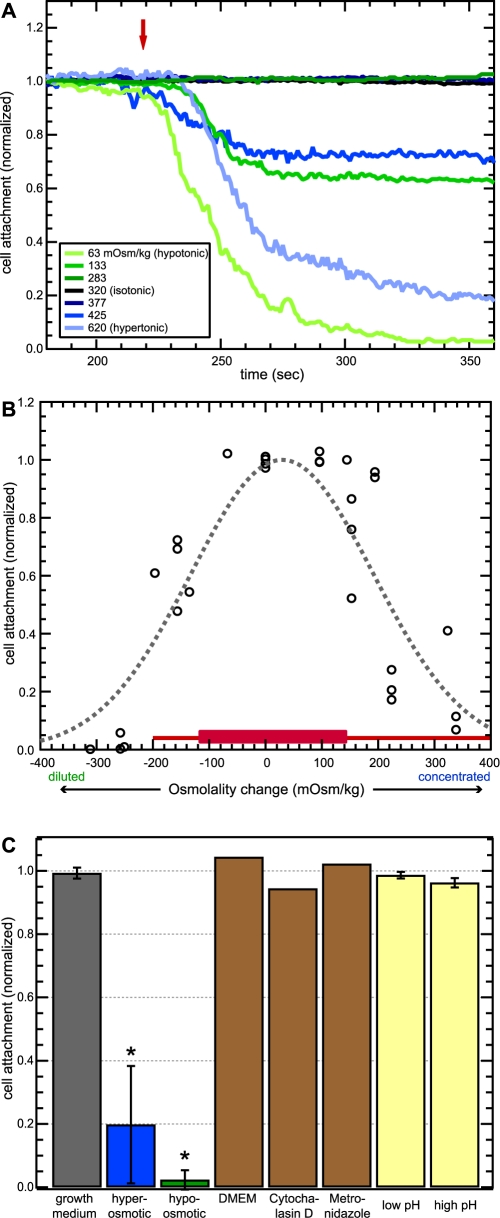
Detachment of Giardia from glass.(A) Detachment from glass during three-minute exposure to growth media of varying osmolality. Traces are normalized counts of attached cells averaged over 3−4 independent experiments for each osmolality. Red arrow marks the time where test media reached cells. Shifting the medium osmolality either progressively higher (from dark blue to light blue traces) or progressively lower (from dark green to light green traces) caused cells to detach in correspondingly greater numbers. (B) Cell attachment levels after three-minute exposure to growth media of varying osmolality for all osmolalities tested. Data fit a Gaussian profile (dashed line). For comparison, the red line indicates the full range of osmolality measured in the human duodenum of fed and fasted subjects and the red box indicates range of mean values [11]. (C) Mean normalized attachment levels in control experiments. Giardia did not show significant short-timescale detachment in the presence of Giardia growth medium, C2BBe-1 growth medium (DMEM), growth media with cytochalasin D (0.1 mM) or metronidazole (30 µg/mL), or in HEPES-based media with elevated pH (pH = 8.03) or low pH (pH = 4.94). Asterisks indicate significant difference from attachment levels in unmodified growth medium (p<0.000005 for both). Error bars indicate standard deviation.